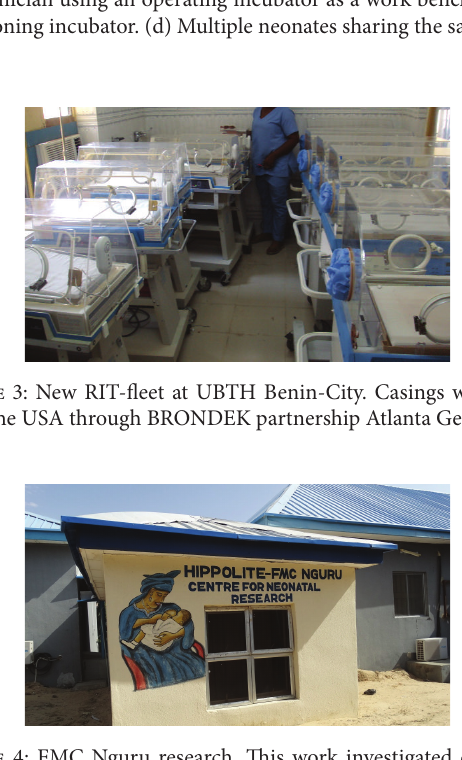
Figure 4: FMC Nguru research. This work investigated evening- fever syndrome in the neonate and recently published findings